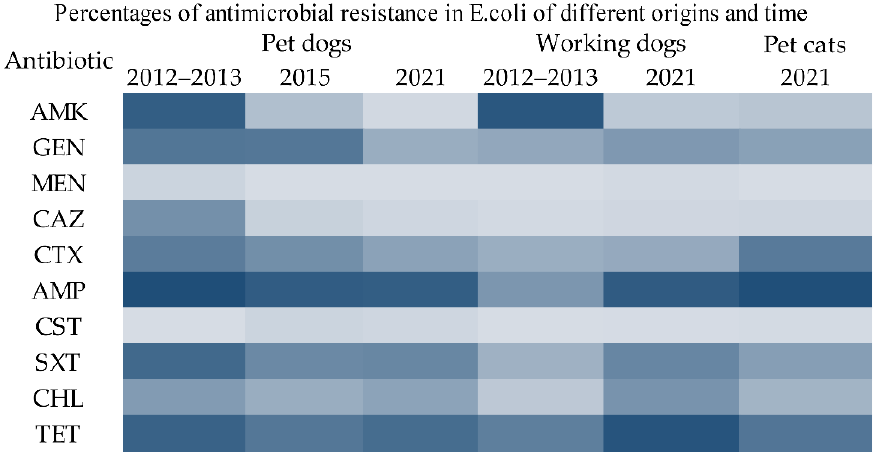
Figure 2. Trends of resistance to various antibiotics of 554 E. coli isolates from different origins between 2012–2021 (the depth of color of the rectangle represents the degree of resistance of the isolates to the antibiotic, and the darker the color, the stronger the drug resistance). AMK, amikacin; GEN, gentamicin; MEN, meropenem; CAZ, ceftazidime; AMP, ampicillin; CST, colistin; SXT, trimethoprim-sulfamethoxazole; CHL, chloramphenicol; TET, tetracycline. Notes: the antibiotics listed in Figure 2 only include the antibiotics tested against all E. coli .